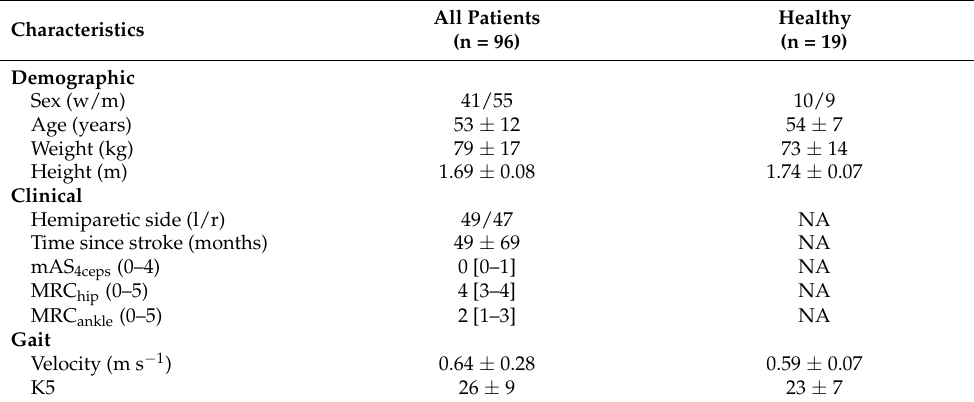
Table 1. Demographic, clinical, and gait characteristics of the participants (all patients and healthy subjects). Values are expressed in numbers, mean ± SD, or median and [1st quartile–3rd quartile]. All Patients Characteristics (n =